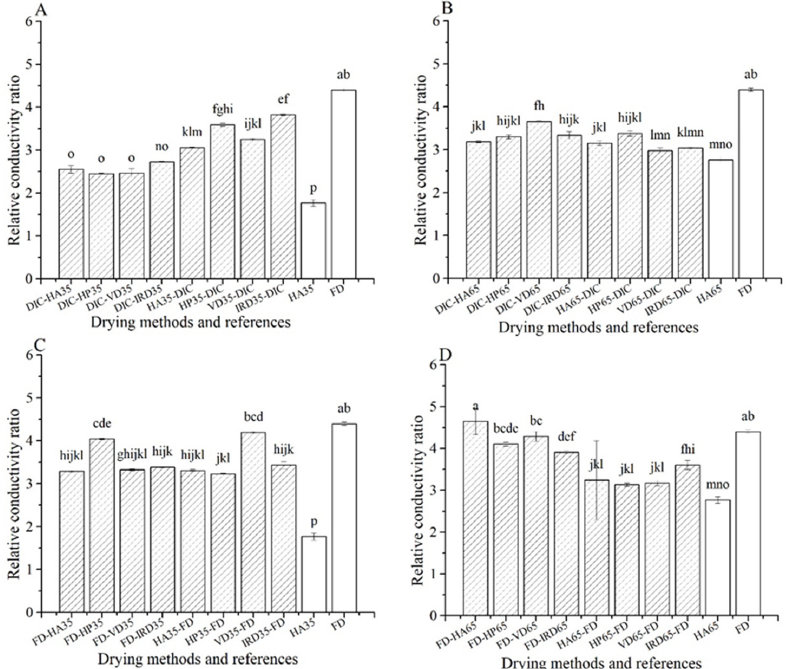
Figure 2. Volume recovery ratio of mushrooms after rehydration with different drying methods (